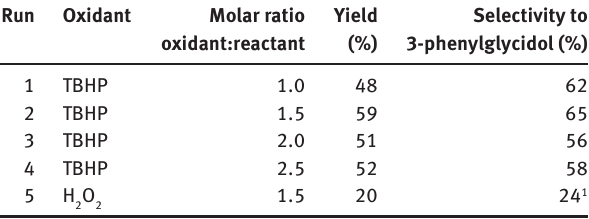
Table 5 Epoxidation reaction of cinnamyl alcohol, effect of oxidants { 3 mol% of VO(acac) , 25 ° C, 2 h, in [bmim][Tf N] } . 2 2 1 Selectivity to cinnamaldehyde is 26% and to benzaldehyde is